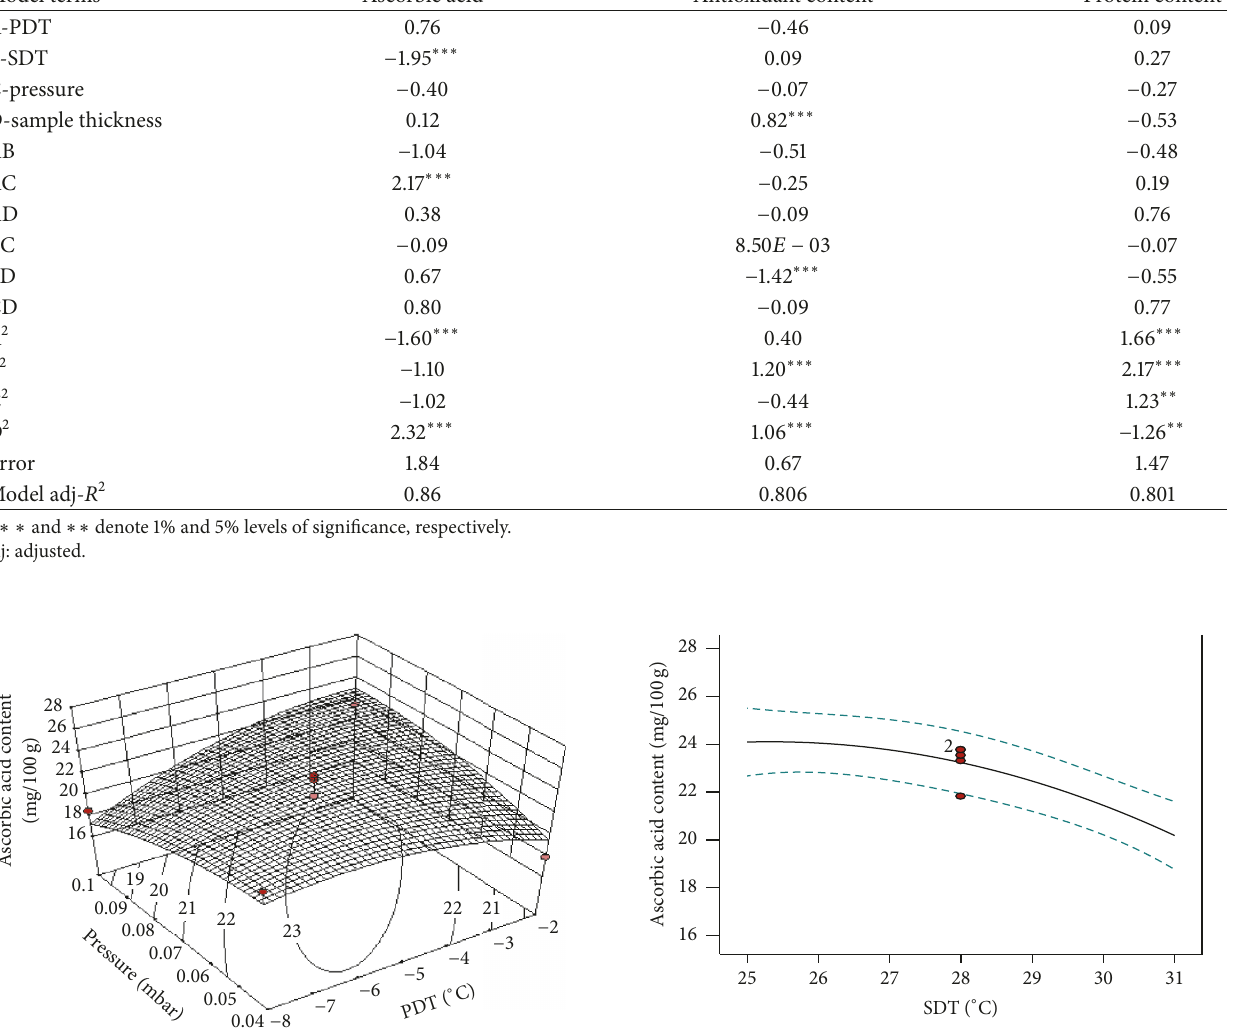
Figure 1: Effect of pressure and primary drying temperature (PDT) on ascorbic acid content.